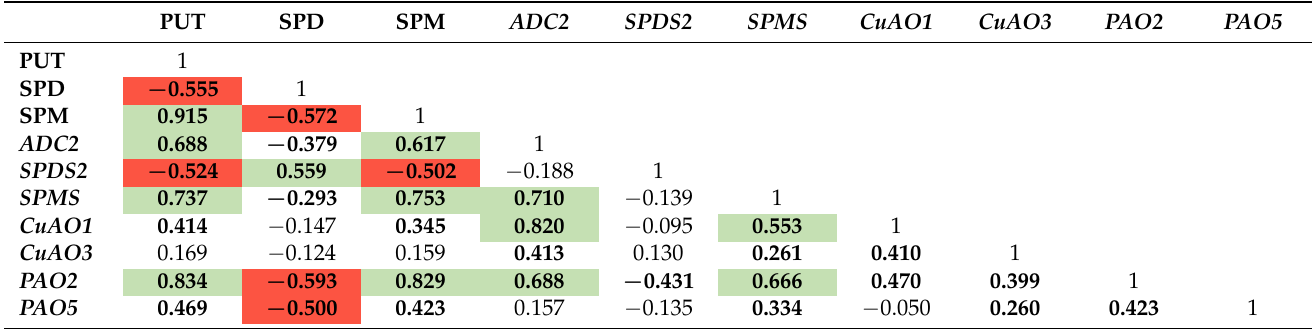
Table 1. Correlation analysis on the polyamine metabolism-related parameters. Strong significant correlations at 0.05 are in bold; a positive correlation is highlighted in green, and a negative